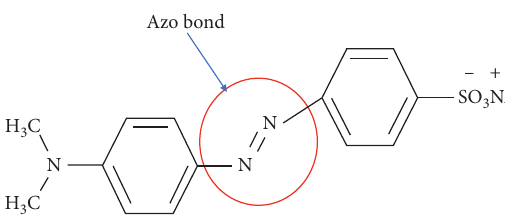
Figure 5: Structure of methyl orange. Methyl orange is an orange organic dye that contains a strong azo bond that is not degradable under normal conditions commonly used in titrations as a pH indicator and textile industries for dyeing and